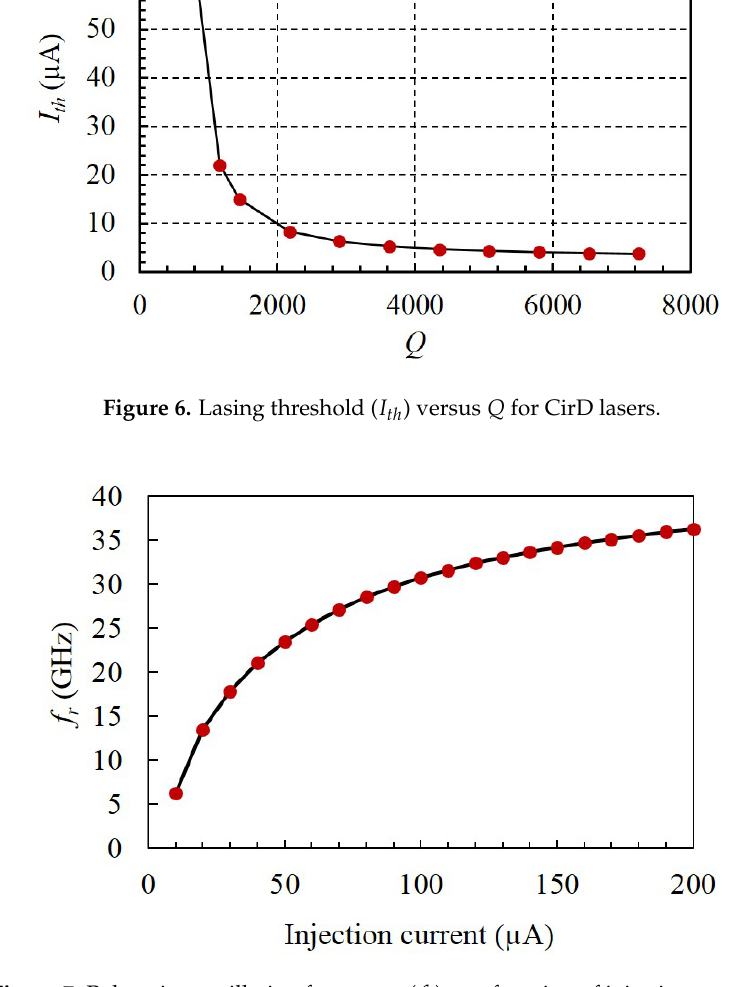
Figure 7. Relaxation oscillation frequency ( f r ) as a function of injection